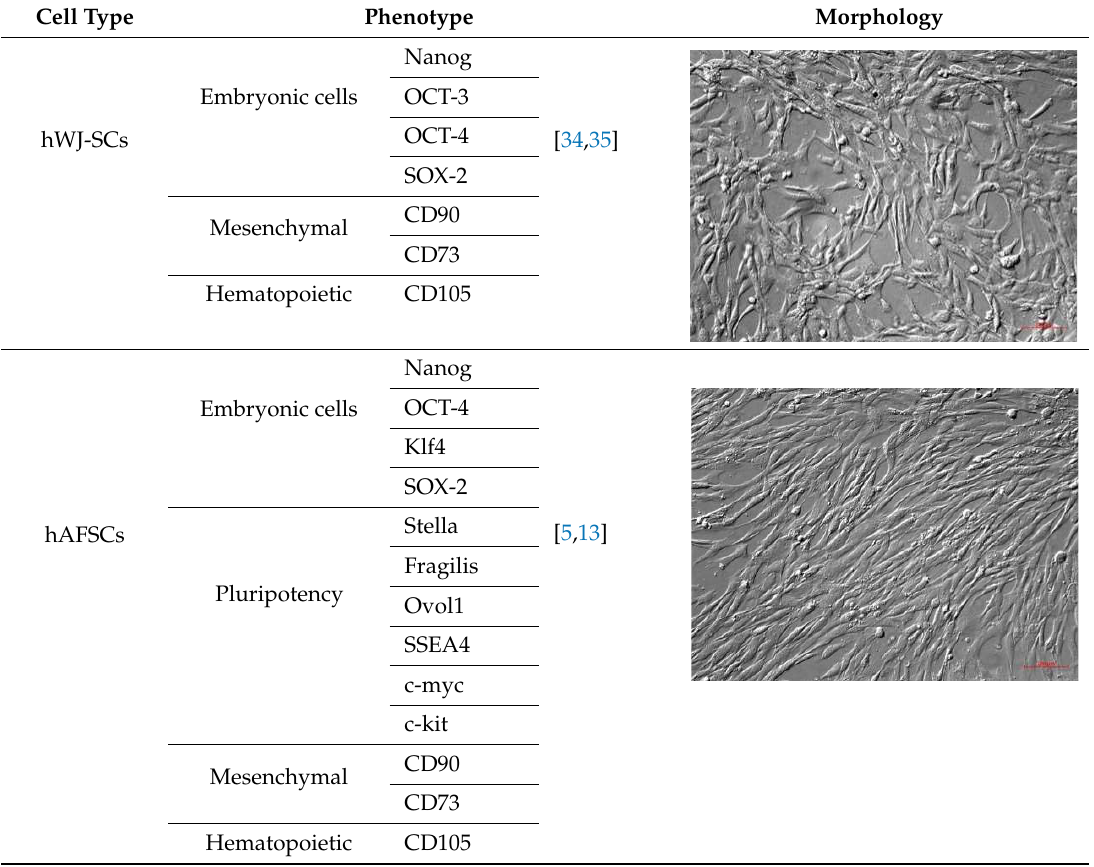
Table 2. Differentiative potential of fetal annex-derived stem